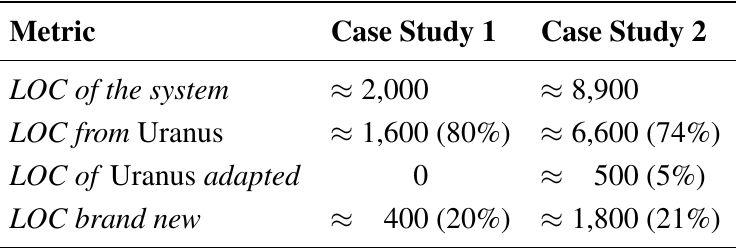
Table 3. Reuse of Uranus Services for the Two Case